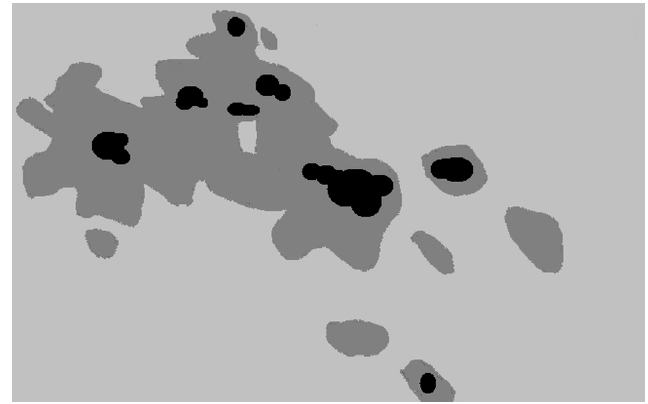
Figure 8. Map of the construction cost coefficient.